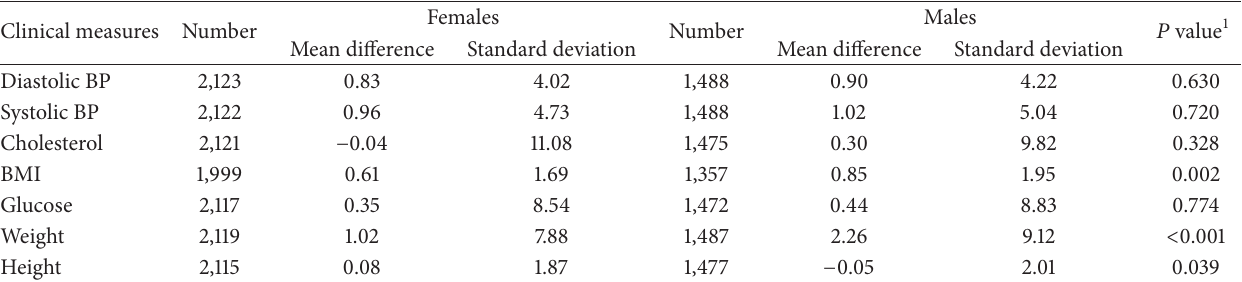
Table 3: Comparison of difference between male and female participants’ self-reported values and recorded values on clinical measures. Clinical measures Number